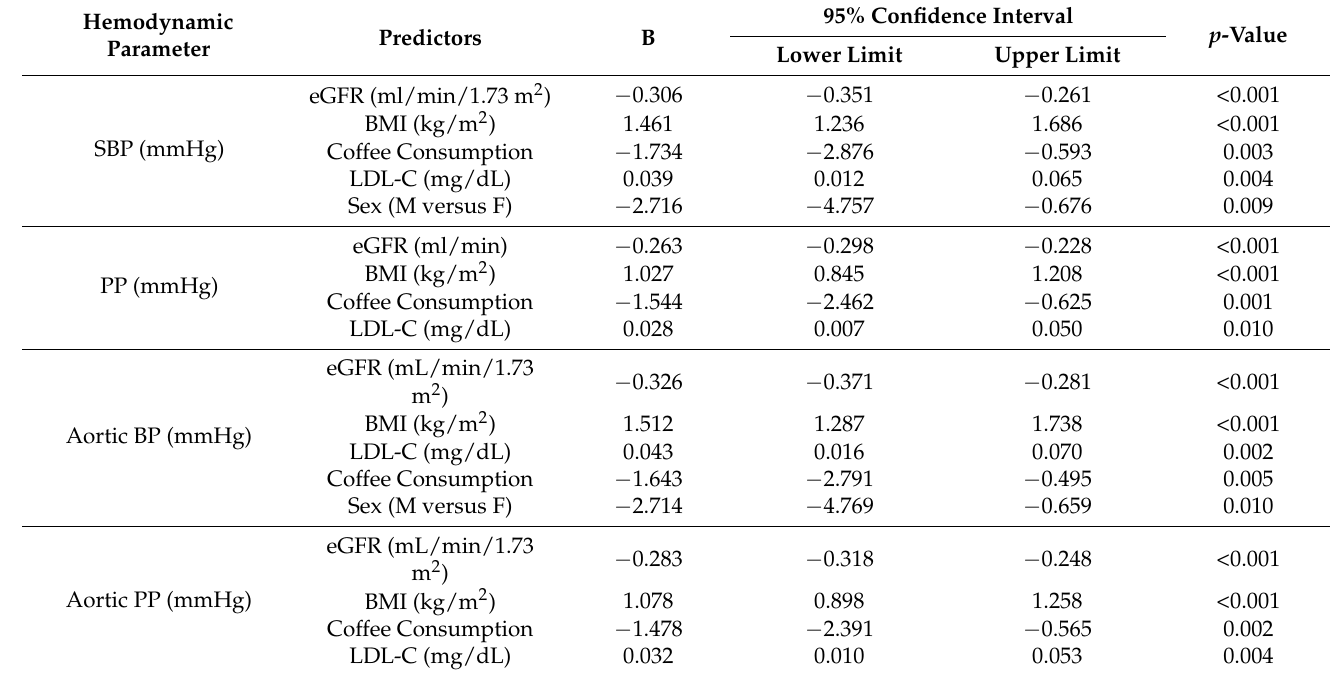
Table 3. Age-adjusted multiple linear regression model identifying the predictors of SBP, PP, aortic BP and aortic PP in the